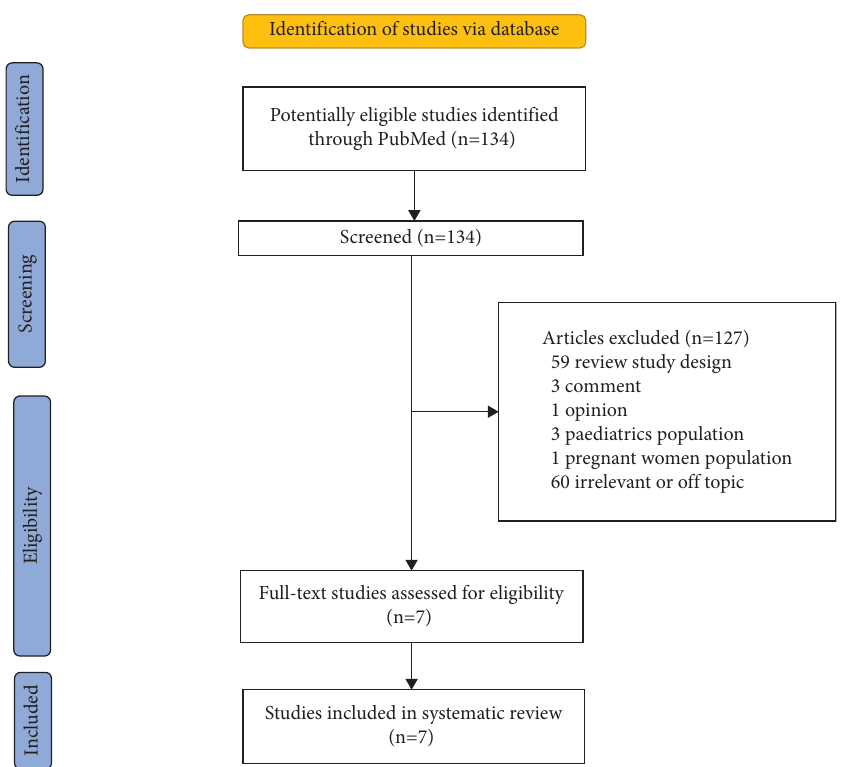
Figure 1: PRISMA fow diagram of study